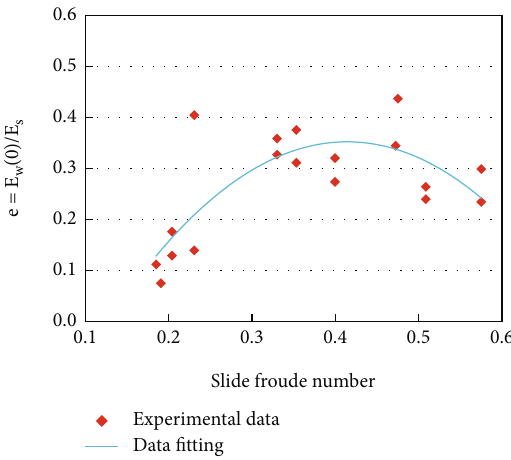
Figure 8: Energy conversion rate at di ff erent Froude numbers.